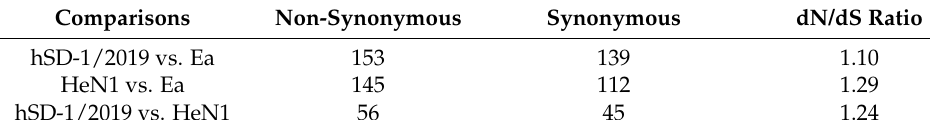
Table 2. Single nucleotide polymorphisms (SNPs) analyses of different PRV strains.